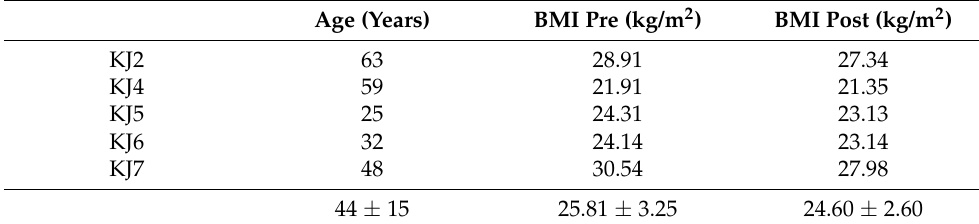
Table 1. Descriptive of